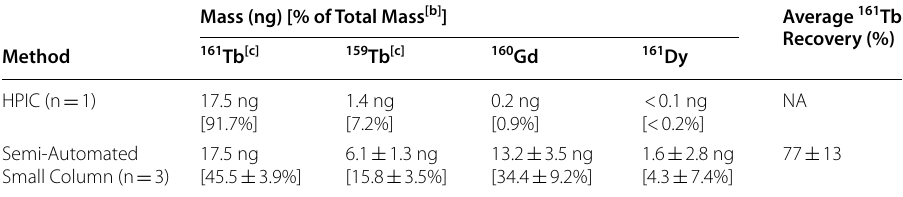
[a] Semi‑automated small column purification was performed on three portions (50 MBq, 50 MBq, and 110 MBq) split from a single batch and the results expressed as average batch material. All results decay corrected to EOS from each purification and normalized to 75 MBq 161 Tb. All samples measured by ICP‑MS. [b] Total Mass defined as the sum of ( 161 Tb was purified > 1 week after the HPIC purified thus accounting for the lower 161 Tb/ 159 Tb ratio